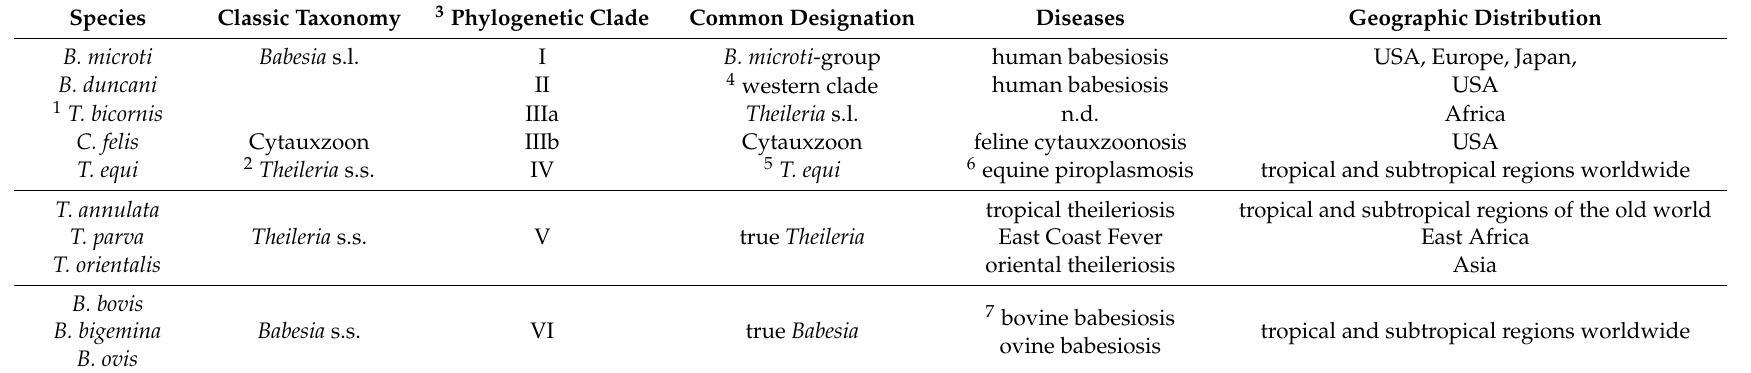
Table 1. Babesia , Theileria , and Cytauxzoon parasites included in this study and their classical taxonomy, molecular phylogeny, common designation, diseases, and geographic